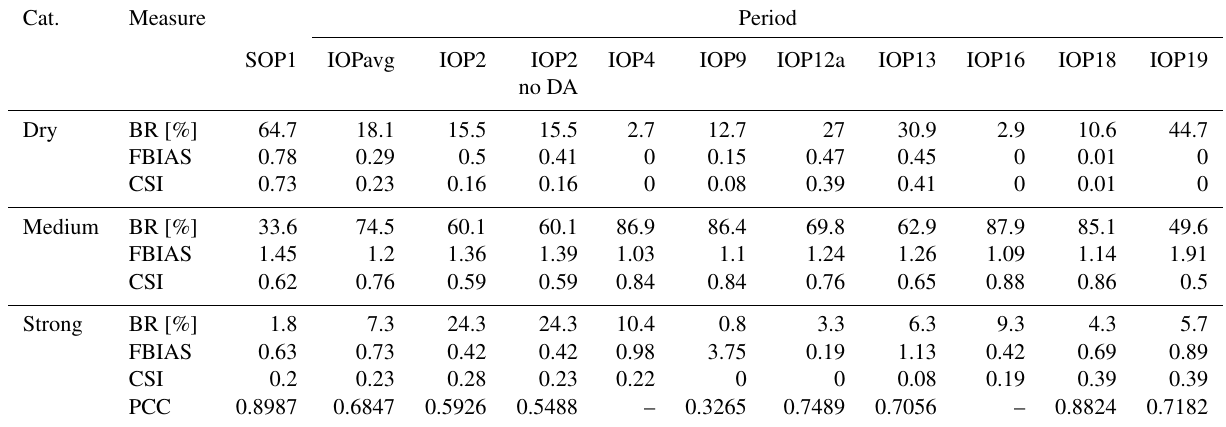
Table 3. Verification measures calculated for 24h accumulated precipitation and for ALADIN 8km model (second column) for three cat- egories (first column), for the whole SOP1 period (5 September to 6 November 2012), only IOP days (IOPavg), and for selected IOPs corresponding to time periods indicated in Table 1 and for IOP2 without data assimilation experiment (IOP2 no DA). Verification measures include base rate (BR), frequency bias (FBIAS), critical success index (CSI) and polychoric correlation coefficient (PCC). Due to zeros in contingency table some PCC scores could not be calculated (IOP4 and IOP16 for ALADIN 8km model). Cat.